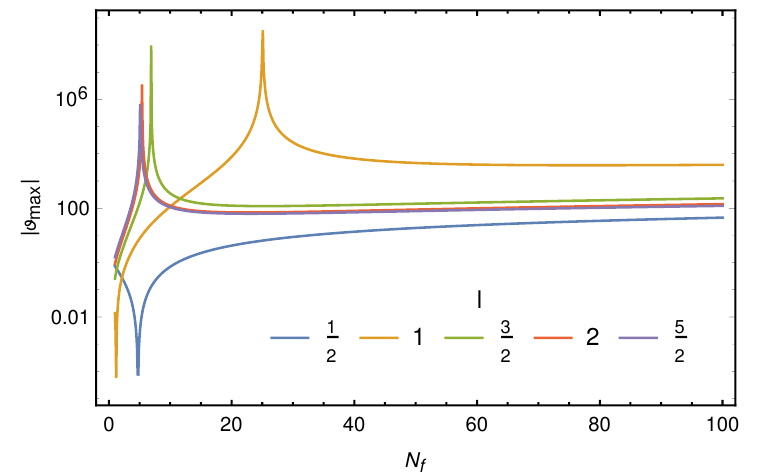
Figure 4 . Behaviour of a given eigenvalue j # j as a function of N f for several values of ‘ in the colorless case. The scaling dimension increases very fast with N f , and only small values of N f ; ‘ produce j # j < O